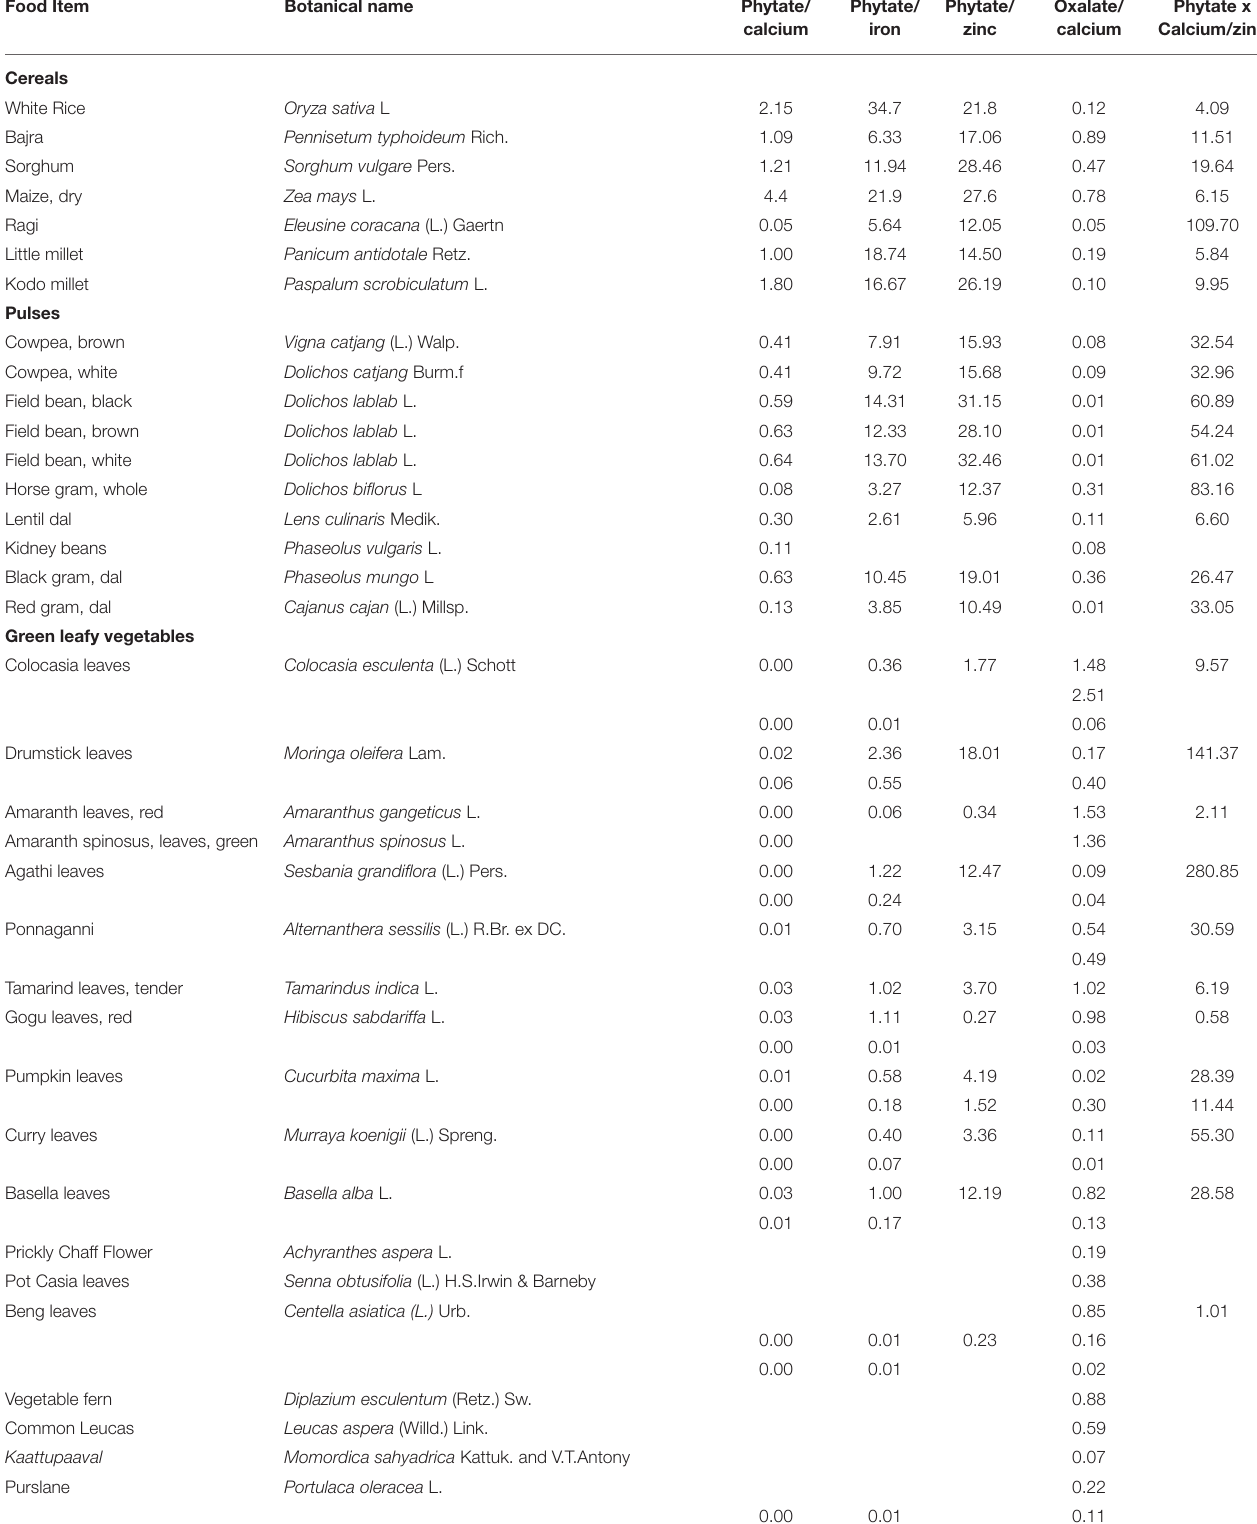
TABLE 2 | Molar ratio indices of Indigenous foods consumed in India ( n = 98). Food